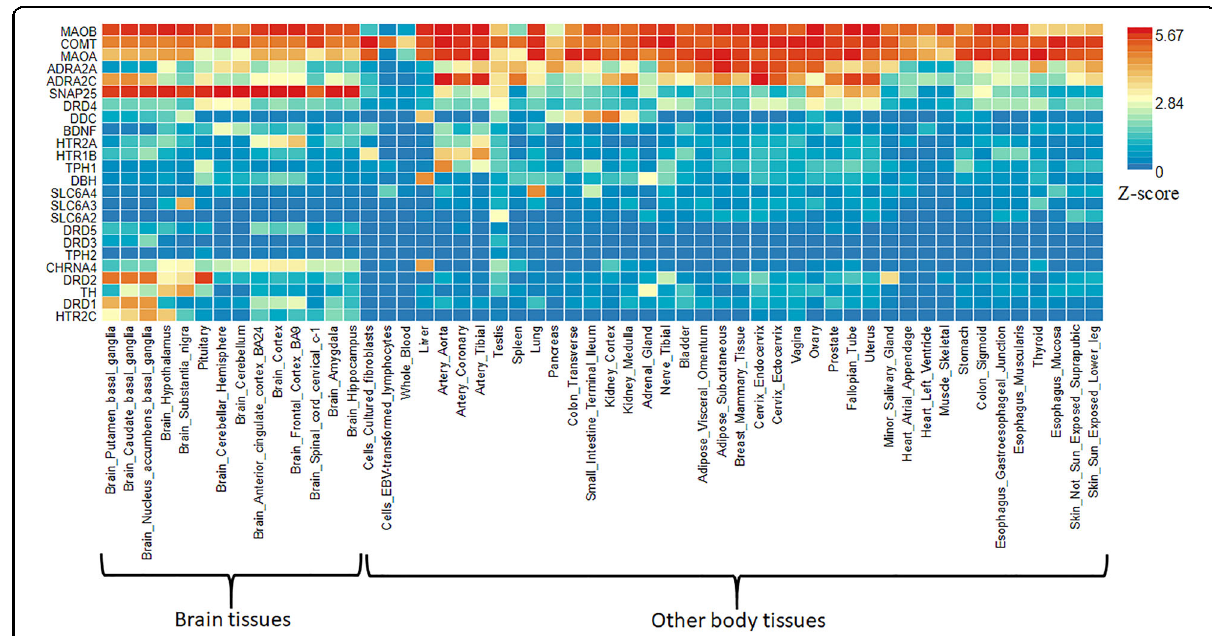
Fig. 6 Gene enrichment analysis of hot genes associated with ADHD. Gene expression heatmaps constructed with GTEX v8 (54 tissue types). The heatmap indicates the signi fi cance of expressed gene modules related to brain regions. Blue to red re fl ects a signi fi cant association of the gene with brian regions as determined by a standardized z score. The gene expression heatmap showing higher relative expression levels of MAOB, SNAP25, COMT, MAOA, ADRA2C, DRD1, DRD2, HTR2C, CHRNA4 , and TH in different brain sites suggest that these genes may be linked with brain areas and are considered as a risk factor for